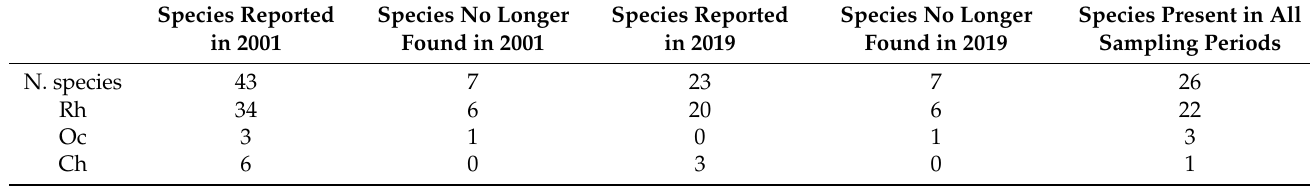
Figure 4. Logarithmic representation of the variations in the number of taxa, Rhodophyta (Rh), Ochrophyta (Oc), and Chlorophyta (Ch) from the 1970s to 2019.